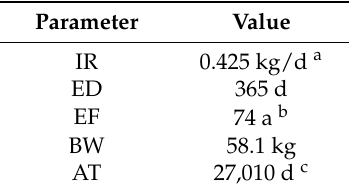
Table 1. Values of parameters in Equation